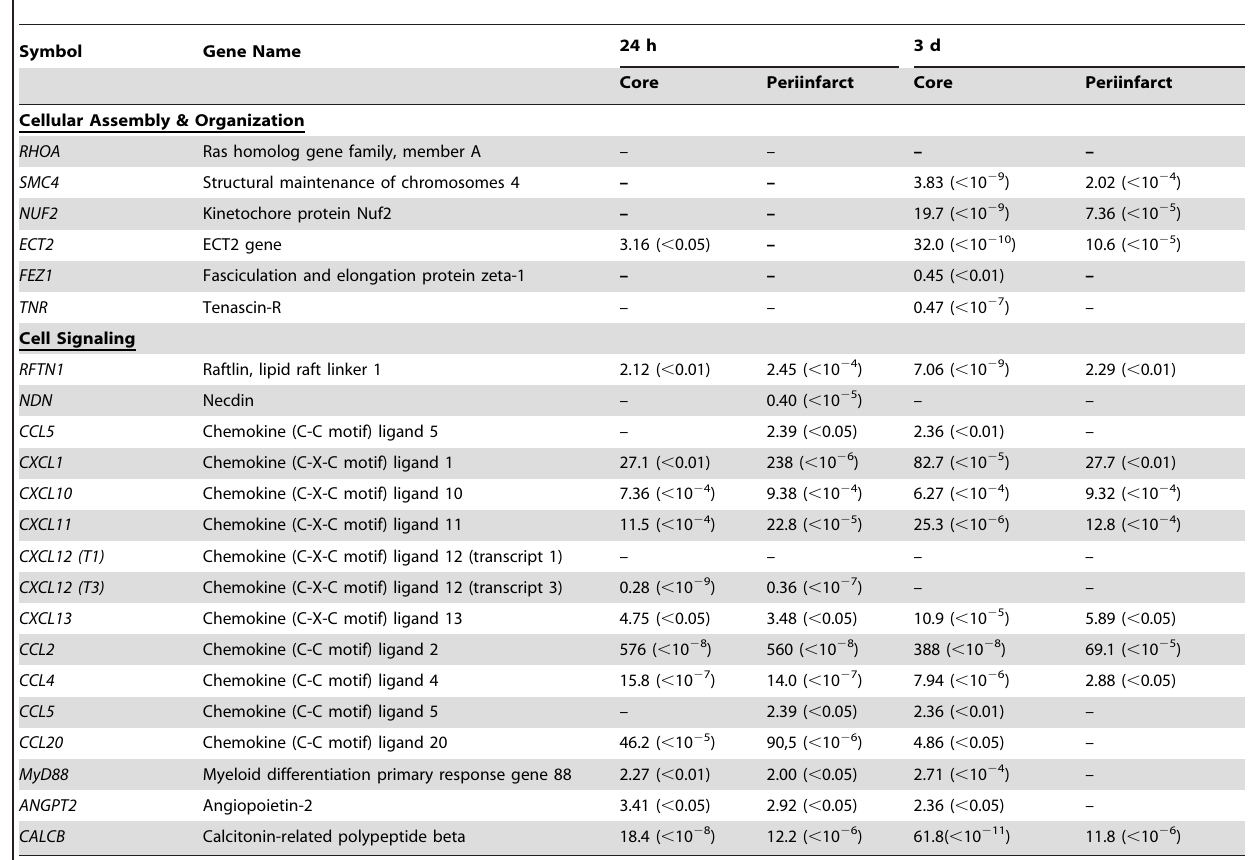
Table 7. Regulation of cellular assembly & organization and cell signaling-associated genes in the core and periinfarct after permanent focal cerebral